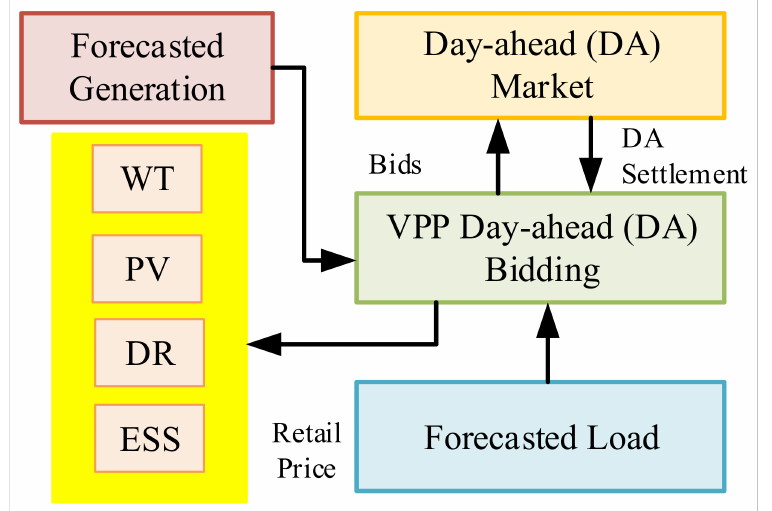
Figure 4. The VPP day-ahead market